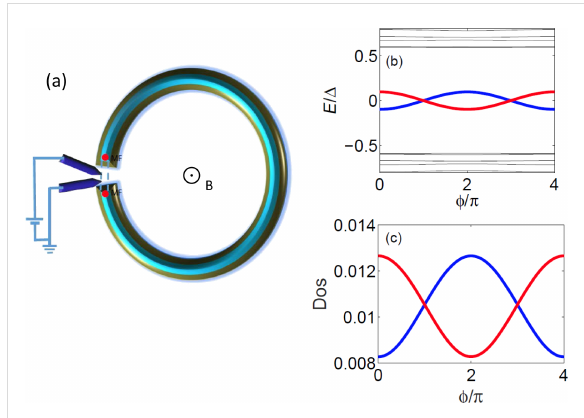
Figure 2: Interference effect in a typical Top-JJ of a ring structure. (a) Schematic setup of the experiment. (b) Energy spectrum of the Top-JJ with the chemical potential μ = − 2 t which lies at the topological region. The two MFs which are localized at the junction interfere with each other and display the 4 π oscillation. (c) DOS for the electron part of the coupled MFs in the Top-JJ. Both the even parity and the odd parity states show parity correlated 4 π oscillation.